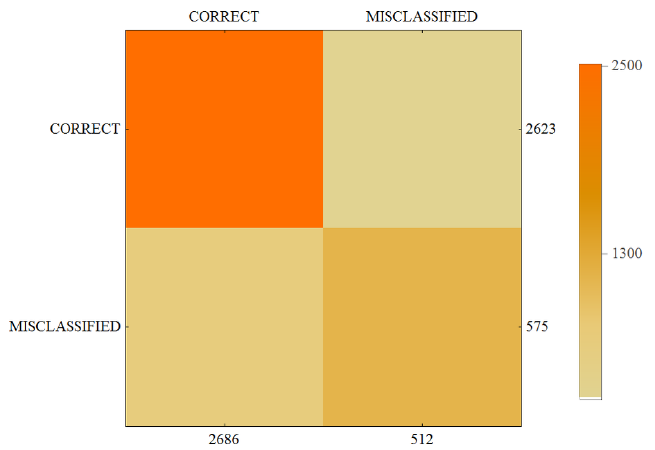
Figure 5. Confusion matrix for User 2.